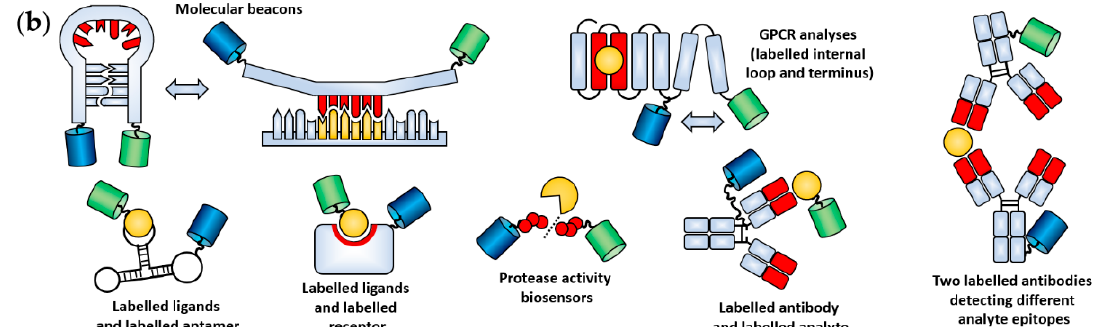
Figure 1. ( a ) Overview of different variations on the Resonance Energy Transfer principle, together with a range of different types of biological recognition element. Red domains indicate recognition elements, and orange domains indicate targeted analytes. ( b ) Examples of different ways that energy donors and acceptors can be combined with biological recognition elements. All illustrations are simplified and not shown to scale. Images were taken from the following sources: The “Fluorescent proteins” image illustrates the Green Fluorescent Protein (doi:10.2210/rcsb_pdb/mom_2003_6). The “Organic dyes” structure shows cyanine. The quantum dot image was taken from Reference [49]. The “Luciferase–Luciferin” image is composed of the Firefly luciferase (doi:10.2210/rcsb_pdb/mom_2006_6) and D-Luciferin as its substrate. The structure of horseradish peroxidase was taken from the Protein Data Bank (1W4E, doi:10.2210/pdb1W4W/pdb). The dark quencher is the black hole quencher BHQ1 from atdbio (https://www.atdbio.com/content/35/FRET-fluorescence-quenchers).